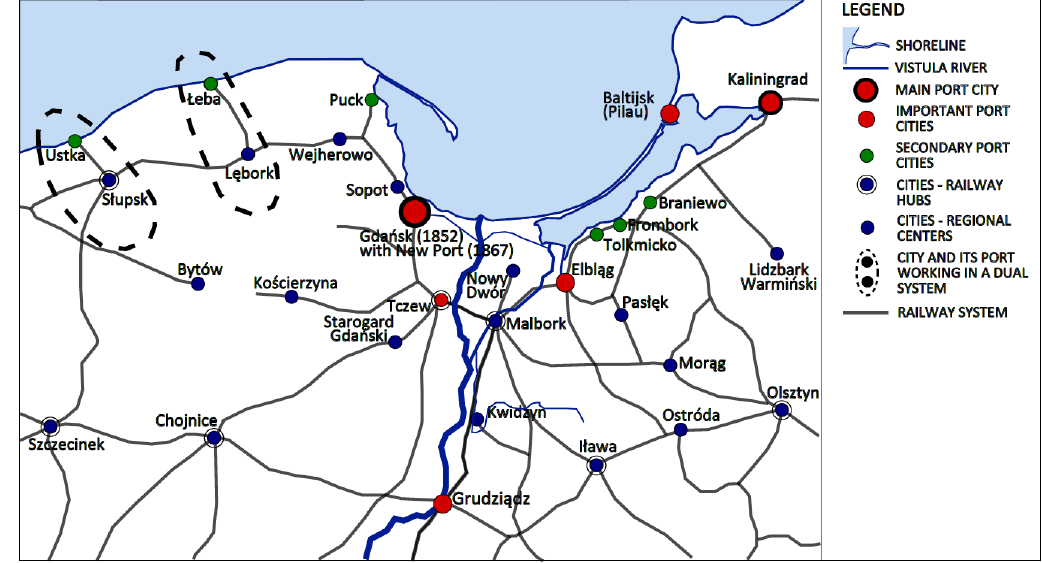
Figure 5. Gdańsk Bay port region geography at the end of the 19th century (around the year 1900). Source: Authors based on Lijewski and Koziarski